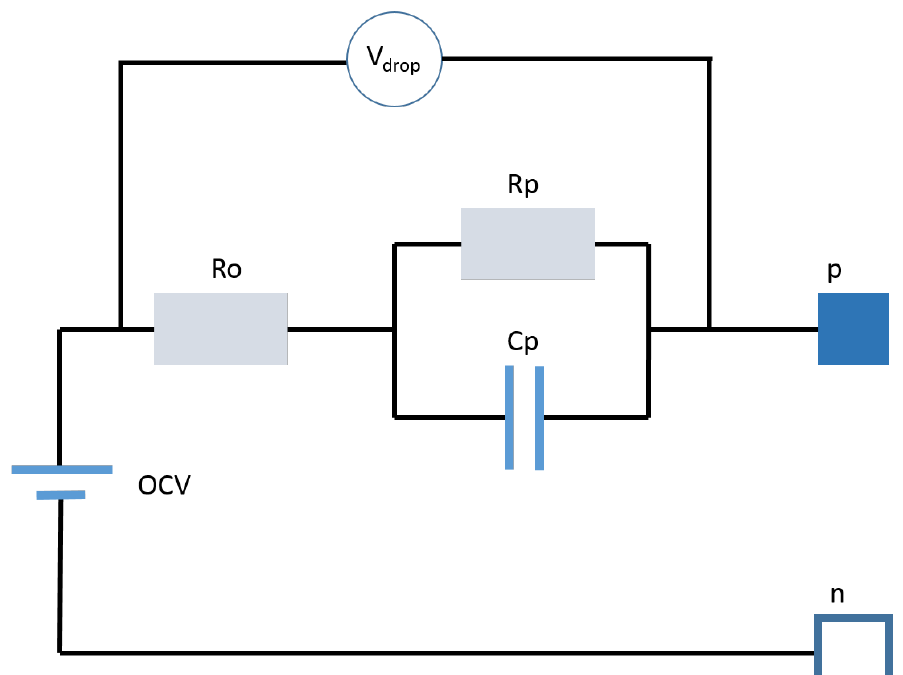
Figure 8. Electric first order resistor-capacitor (RC) model for the battery, scaled by number of cells in series using parameter nS_cells, seen in the top right.